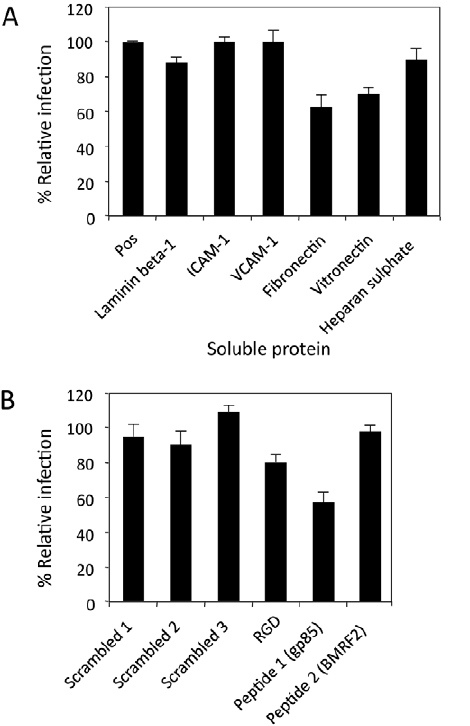
Figure 8. Inhibition of direct polarised epithelial cell infection. Recombinant EBV carrying a deletion for gp350 ( D gp350) was used to directly infect polarized tonsillar epithelial cells from the basolateral surface. (A) Purified D gp350 at an MOI 100 was pre-incubated for 1 hour at 37 u C with proteins of the extracellular matrix: laminin b -1, fibronectin, vitronectin, heparan sulphate, or expressed on the surface of epithelial cells: ICAM-1 or VCAM-1 as a control. The virus was then incubated for 1 hour with the epithelial cells. Epithelial infection was monitored by flow cytometry for GFP and plotted as % infection (mean of triplicates) relative to the positive control. (B) The D gp350 virus was pre-incubated with an RGD peptide, a peptide containing the KGD motif specific to gp85 and a peptide containing an RGD motif specific to BMRF2, plus control scrambled peptides in binding buffer for 1 hour at 37 u C. The virus was then incubated for 1 hour with the epithelial cells. Epithelial infection was again monitored by flow cytometry for GFP expression and plotted as % infection relative to a positive control without peptides.